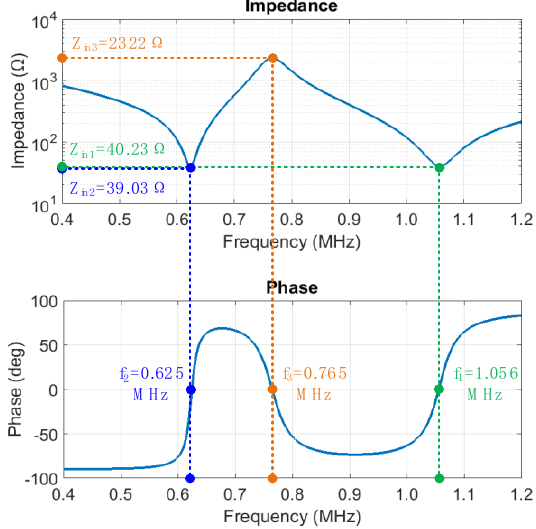
Figure 11. Relationship between input impedance and working frequency.